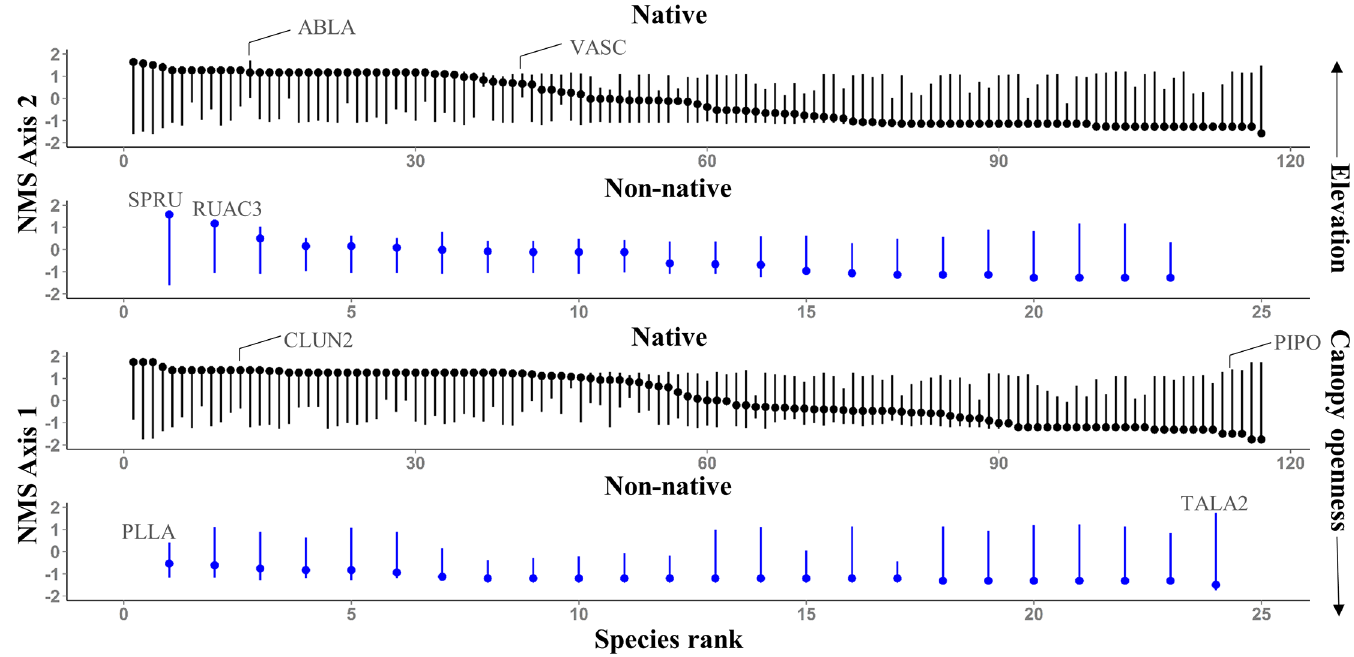
Fig 7. NPMR generated ordination Axes 1 and 2 ranges for species (n = 141) included in NMS ordination. Species were ranked by their optima (points) along each axis. Lines connect between lower (2.5 th percentile) and upper (97.5 th percentile) range boundaries. ABLA ( Abies lasiocarpa ), VASC ( Vaccinium scoparium ), SPRU ( Spergularia rubra ), RUAC3 ( Rumex acetosella ), CLUN2 ( Clintonia uniflora ) PIPO ( Pinus ponderosa ), PLLA ( Plantago lanceolata ), TALA2 ( Taraxacum laevigatum